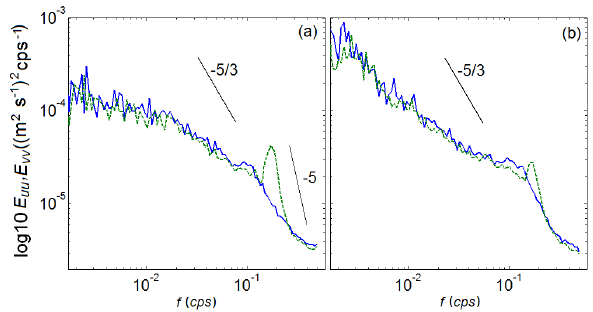
Fig. 6. Power spectral density of (a) cross-shore, E uu and (b) along-shore, E vv components of velocity at 4 mab for calm (solid) and storm (dashed) periods as in Fig. 5.